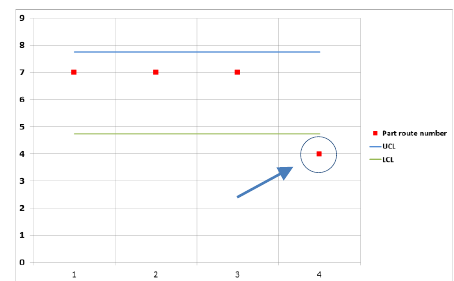
Fig. 17. An example of machine loads fallen out of the control limits but is not an idle machine